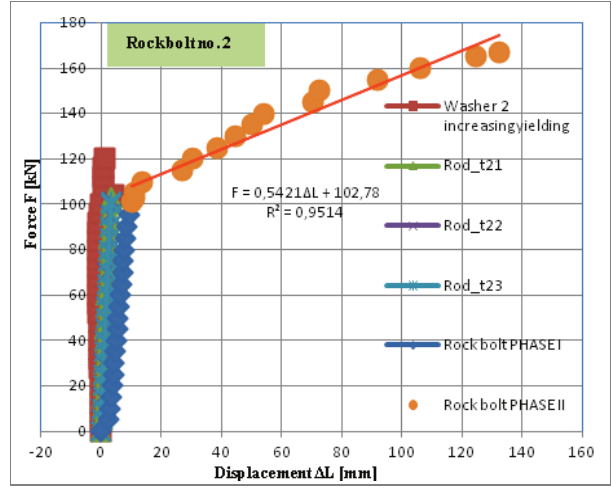
Fig. 17. The detailed loading characteristics for the components of the rock bolt support No. 1